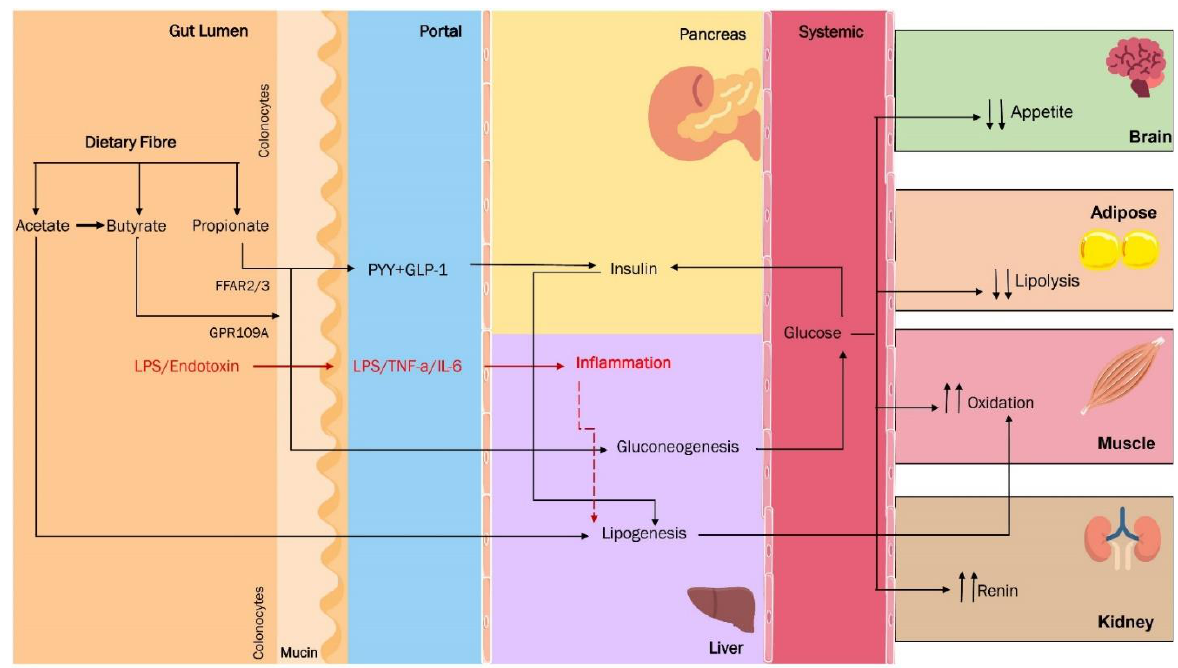
Figure 3. Dietary fibre and its effects on human metabolism and gut microbiota.